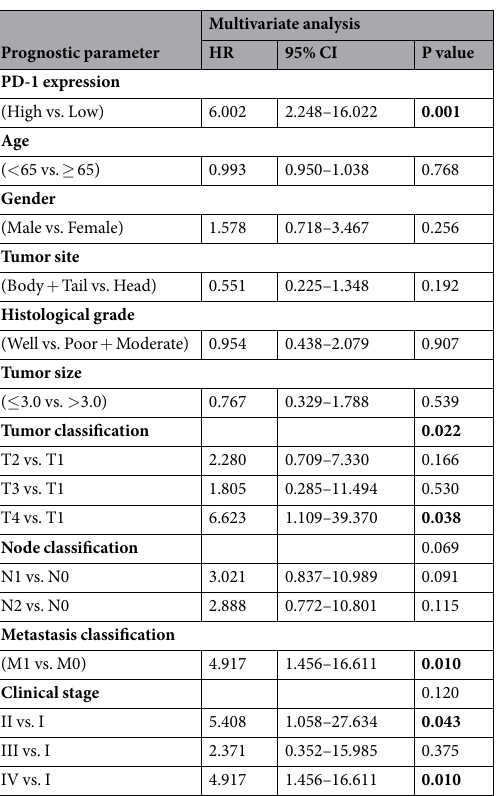
Table 2. Multivariate Cox regression analysis of prognostic parameters for survival in patients with pancreatic ductal adenocarcinoma (PDAC). HR: Hazard ratio; CI: Confidence interval. The bold numbers indicate significant differences with P <